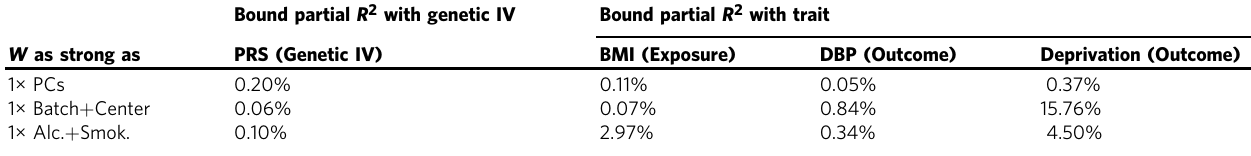
Table 2 Bounds on the maximum explanatory power of W (partial R 2 ), if it were as strong as: (i) 20 leading genomic principal components (1× PCs); (ii) observed batch and center (1× Batch + Center); and, (iii) smoking and drinking status (1× Alc. + Smok.).